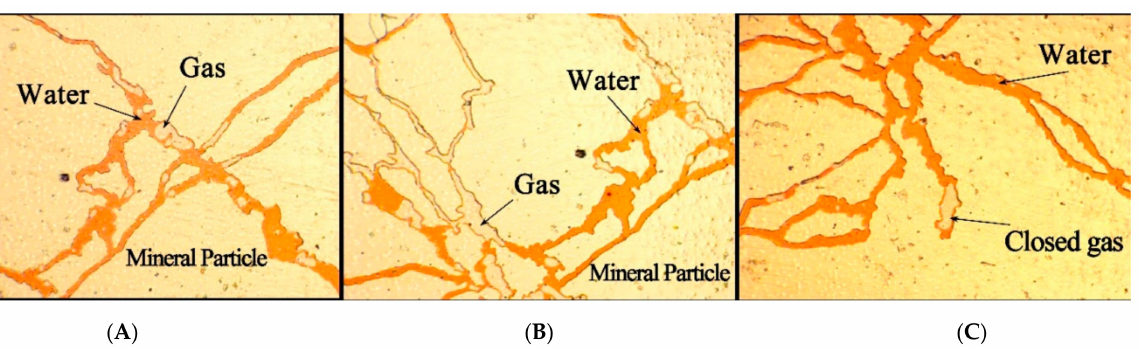
Figure 5. Microscopic interpretation of residual gas formation in rock core after gas–water mutual drive. ( A ) a closed gas formed by the card break; ( B ) a closed gas formed by the circumflow; ( C ) a closed gas formed by the blind